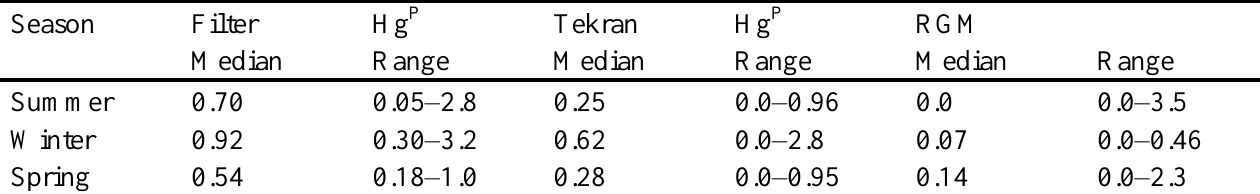
Table 2. Statistical summary as a function of season. All values are stated in